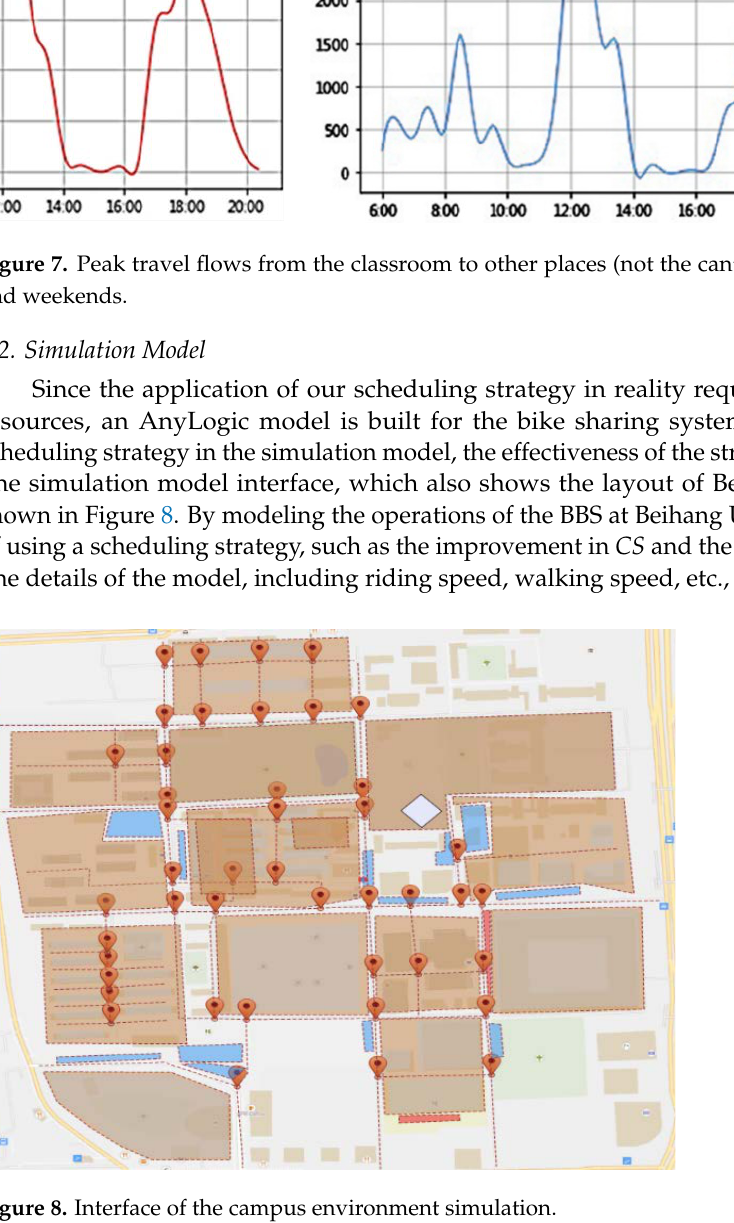
Figure 7. Peak travel flows from the classroom to other places (not the canteen) on working days and weekends.